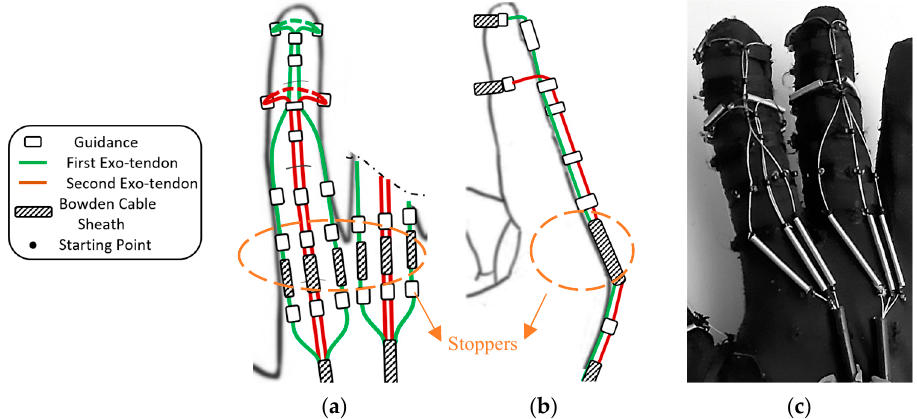
Figure 4. The proposed extension mechanism, ( a ) Top view (dorsal side) and ( b ) Side view, including the exotendons paths, the positions of the guidance, the starting point, the Bowden cable sheaths, and the stoppers for preventing hyperextension of the MCP joint. ( c ) The soft glove with the mechanism implemented (dorsal side).